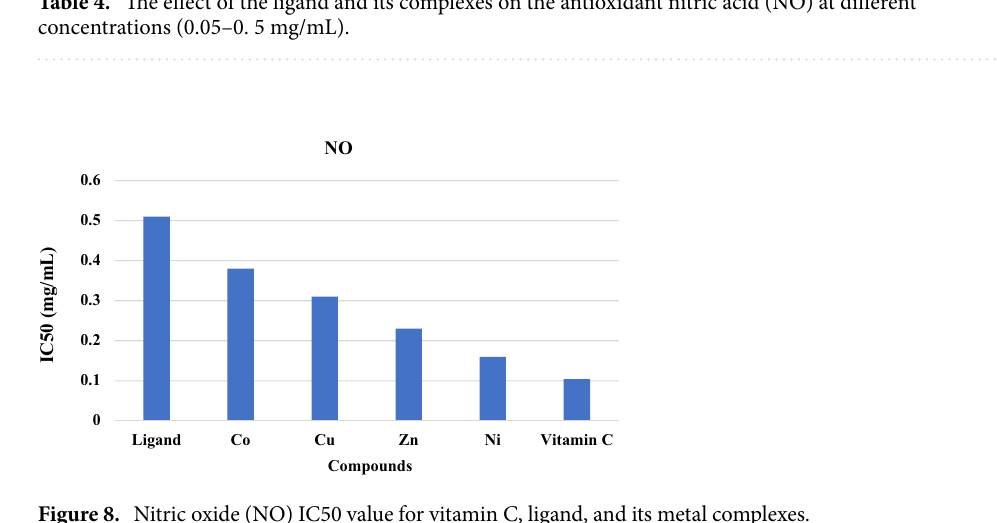
Figure 8. Nitric oxide (NO) IC50 value for vitamin C, ligand, and its metal